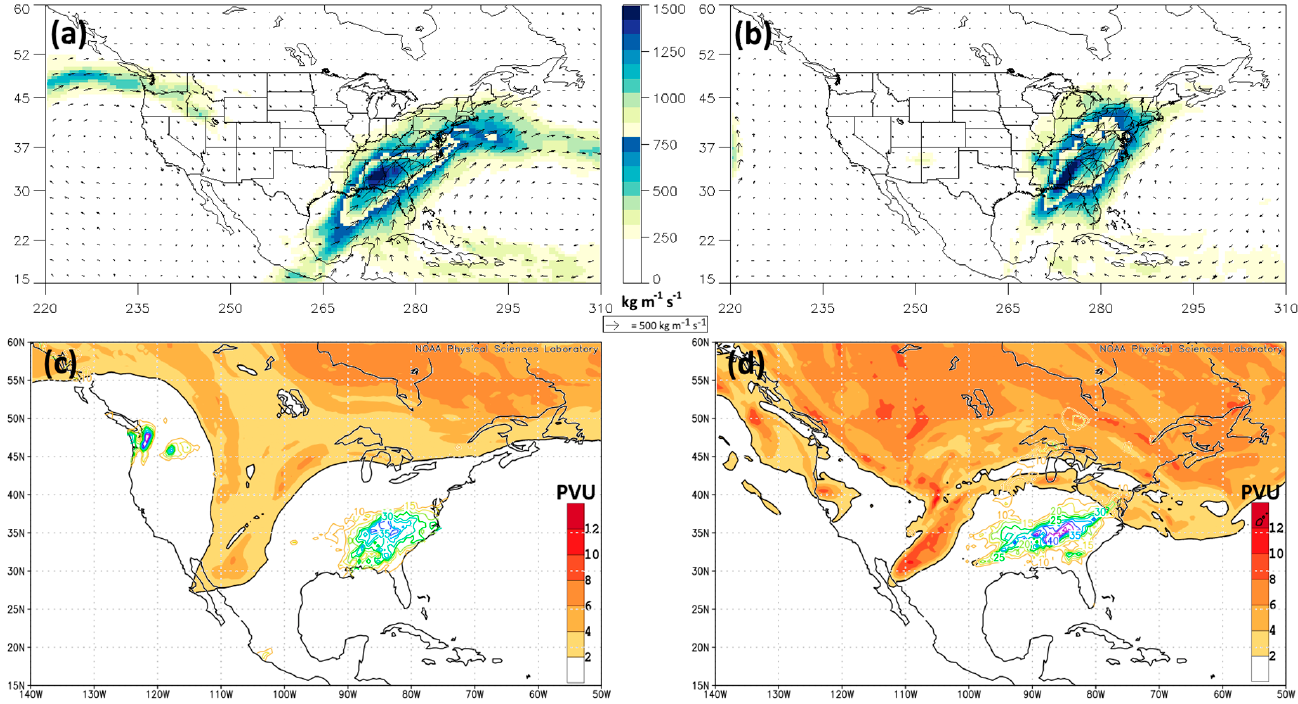
Figure 6. GFS − analyzed fields of IVT (kg m − 1 s − 1 ) valid at: ( a ) 1200 UTC 6 February 2020, and ( b ) 0600 UTC 13 April 2020. Reference IVT vector is plotted under the IVT color bar. GFS-analyzed fields of isentropic potential vorticity at: ( c ) 1200 UTC 5 February 2020 on the 315 K surface, and at ( d ) 0600 UTC 12 April 2020 on the 325 K surface. Color bar in panels ( c , d ) are in PV Units (PVU), where= 1 PVU = 10 − 6 K kg − 1 m 2 s − 1 . Shading is for 2 PVU or greater, where the 2 PVU (thick black) contour corresponds to the intersection location of the dynamic tropopause with the isentropic surface. Panels ( c , d ) also contain contours of daily mean precipitation accumulation (mm) for the: ( c ) 72 h, and ( d ) 48 h period commencing 5 February and 12 April 2020, respectively. Daily mean precipitation contours start at 10 mm, with an interval of 5 mm. Maximum daily mean precipitation contour for panel ( c , d ) is 40 and 50 mm, respectively. Precipitation plots created using a web page maintained by the NOAA Physical Sciences Laboratory based on Climate Prediction Center Global Unified Gauge-Based Analysis of Daily Precipitation data (accessed online https://psl.noaa.gov/data/gridded/data.cpc.globalprecip.html, accessed on 3 June